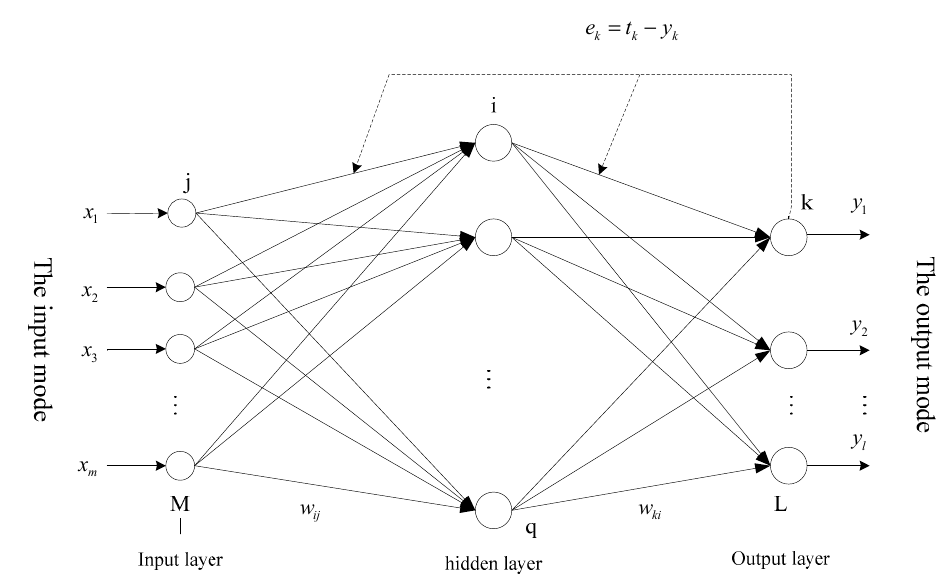
Figure 1. Back propagation neural network.